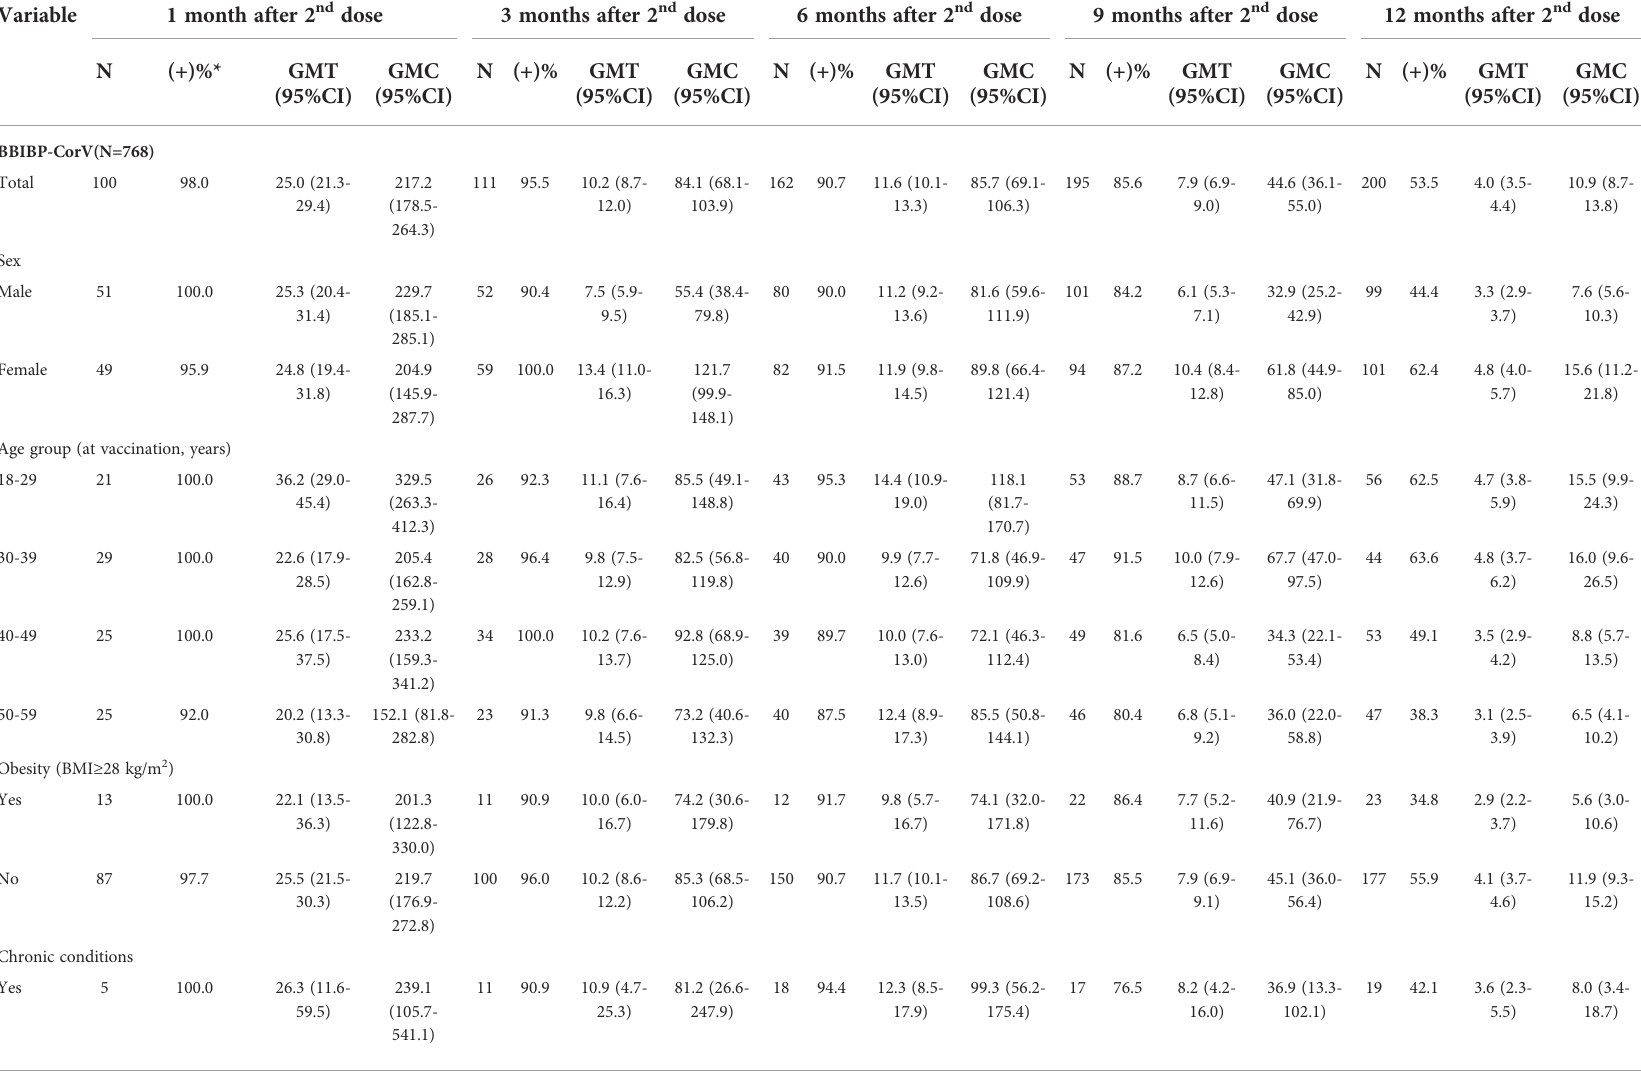
TABLE 1 Participant characteristics and nAb responses to inactivated COVID-19